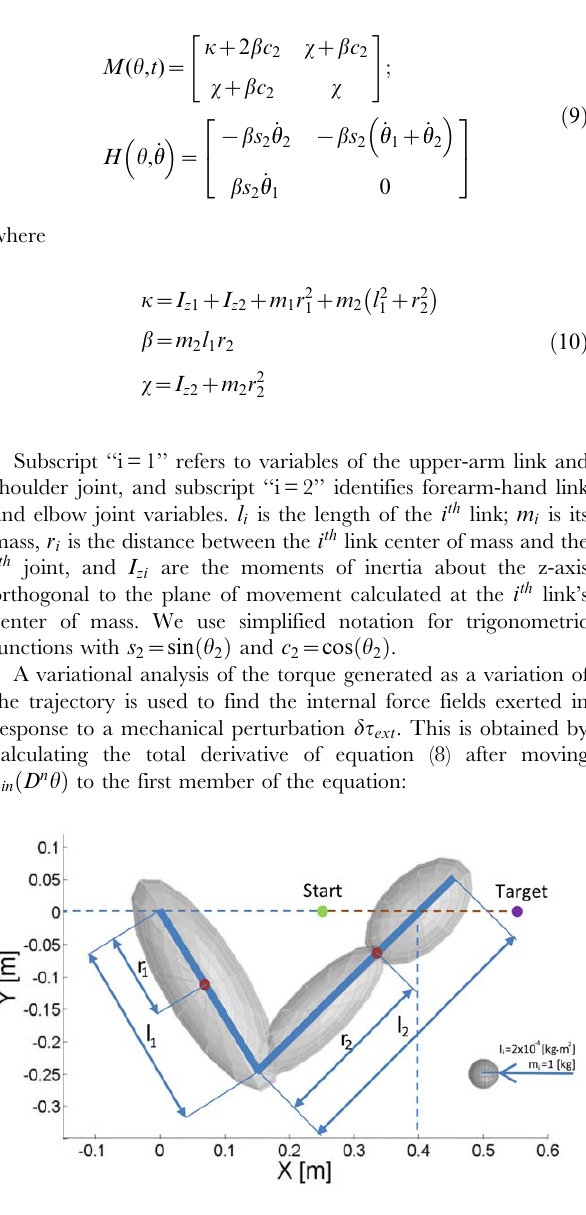
Figure 1. Representation of the double-pendulum model of the arm. The centers of the inertial ellipsoids represented in the figure are located at the centers of mass of the body segments. The length of the upper arm is l 1 , and the center of mass is at r 1 from the shoulder center of rotation. Hand and forearm are considered as a unit of length l 2 with no joint at the wrist. The resulting center of mass for the segment is obtained by the combination of those of the hand and forearm and is located at r 2 from the elbow. The size of each ellipsoid depends on both mass and inertial tensor of the segment. The dimensions of each ellipsoid along the major and minor axes (eigenvectors) are computed r ffiffiffiffiffiffiffiffiffiffiffiffiffiffiffiffiffiffiffiffiffiffiffiffiffiffi 5 tr I ð Þ { 2 I k ½ , where I k are the principal moments of inertia of as e k ~ the tensor I , and m is the mass of the segment. During simulated movements, the hand’s center of mass follows the trajectory shown as the dashed brown line. In the figure the hand center of mass is at position (0.4,0)m, which is the configuration used for the postural tests. doi:10.1371/journal.pone.0033086.g001 PLoS ONE |